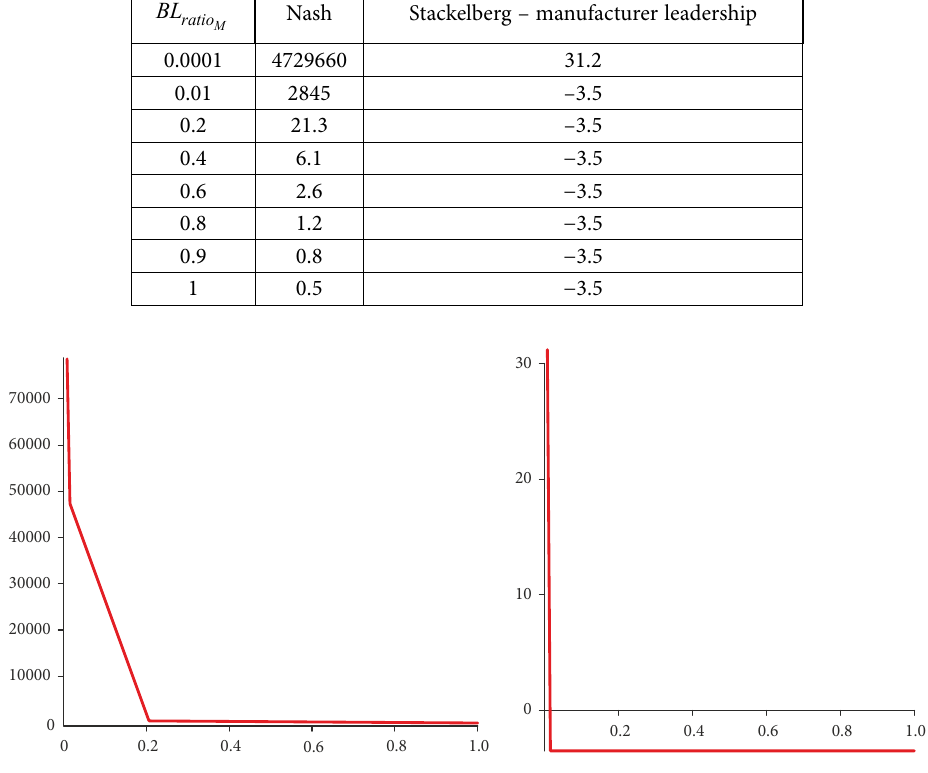
Figure 2. Nash model behavior on BL ratio changes Figure 3. Stackelberg model behavior on BL